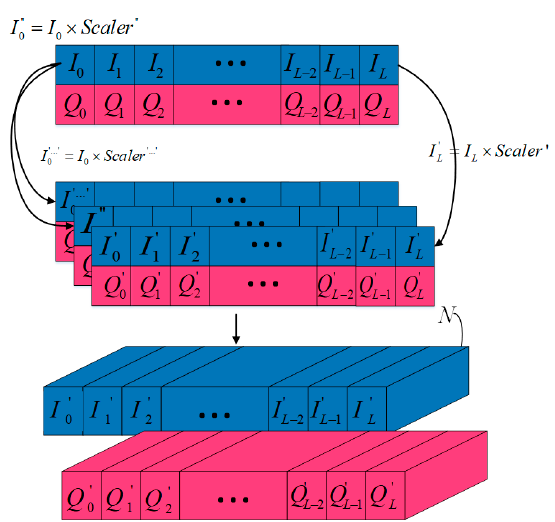
Figure 5. Operational process of data augmentation processing.